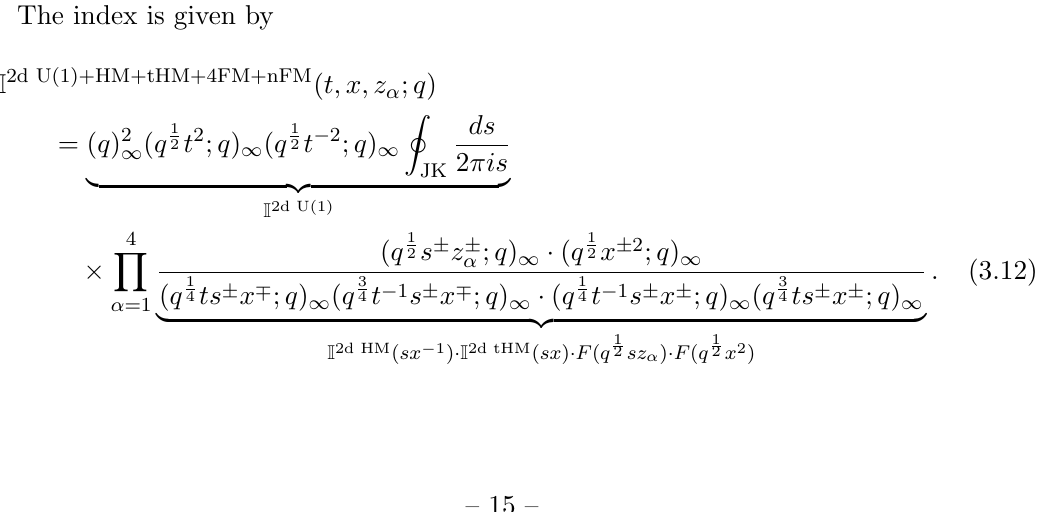
Figure 3 . The brane box configuration of 2d hypermultiplet, a charged twisted hypermultiplet, four charged Fermi multiplets and a neutral Fermi multiplet and the S-dual